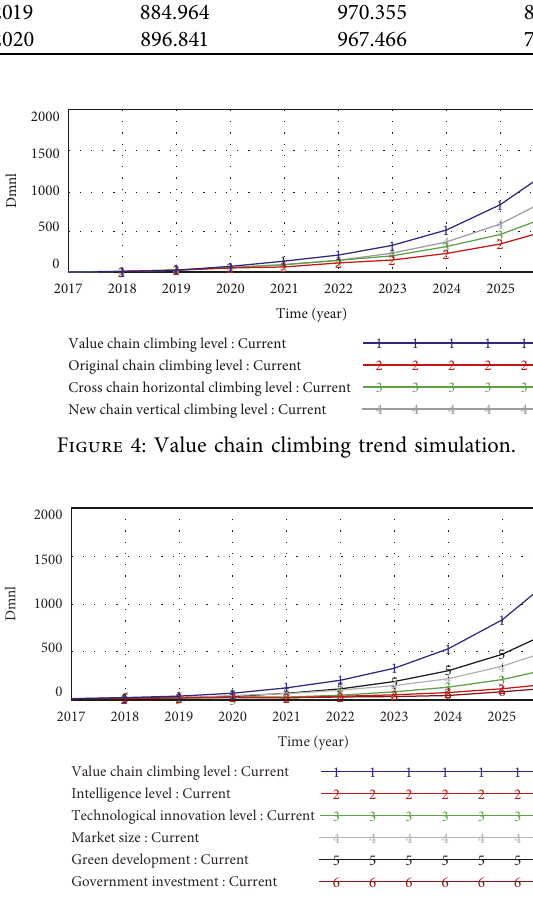
Figure 5: Simulation of the influence of various factors on value chain climbing.